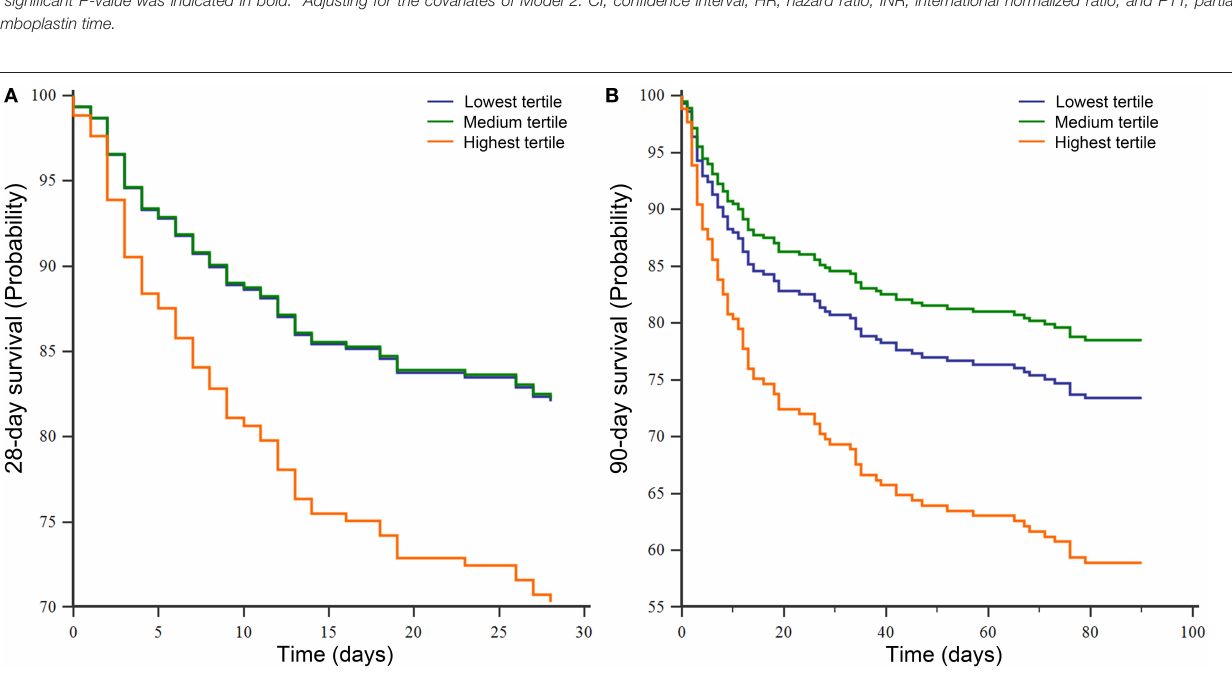
FIGURE 3 | The survival curves of Cox regression analysis for subset analysis in the MIMIC III database. (A) 28-day survival curve and (B) 90-day survival curve. MIMIC III, Medical Information Mart for Intensive Care